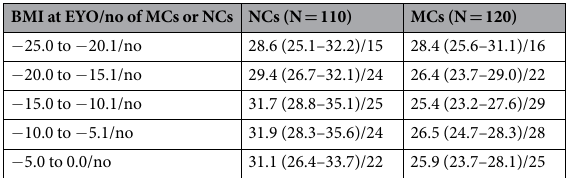
Table 2. Mean body mass index (BMI) and number of preclinical (CDR = 0) mutation carriers (MCs) and non- mutation carriers (NCs) in 5-year time segments from − 25 to 0 years of estimated symptom onset (EYO). Note: Displayed are means and 95% confidence intervals (in parentheses) of body mass index (BMI) and the number of MCs and NCs in 5-year time segments starting from − 25 to 0 years of EYO; CDR = Clinical Dementia Rating scale.